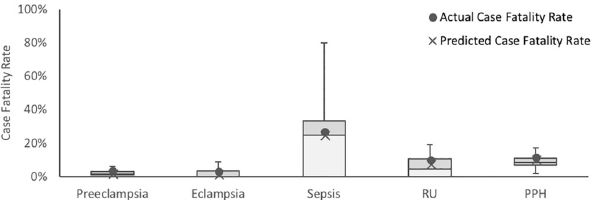
Fig 5. Comparison of case fatality rates for each complication outputted by the calibrated model and case fatality rates recorded by Herklots et al for the five complications incorporated in the model. Box plots represent distribution of data over n = 50 identical simulations. Outliers have been omitted from the box plots for clarity. Predicted case fatality rate is depicted as the mean of each data set, inclusive of outliers.